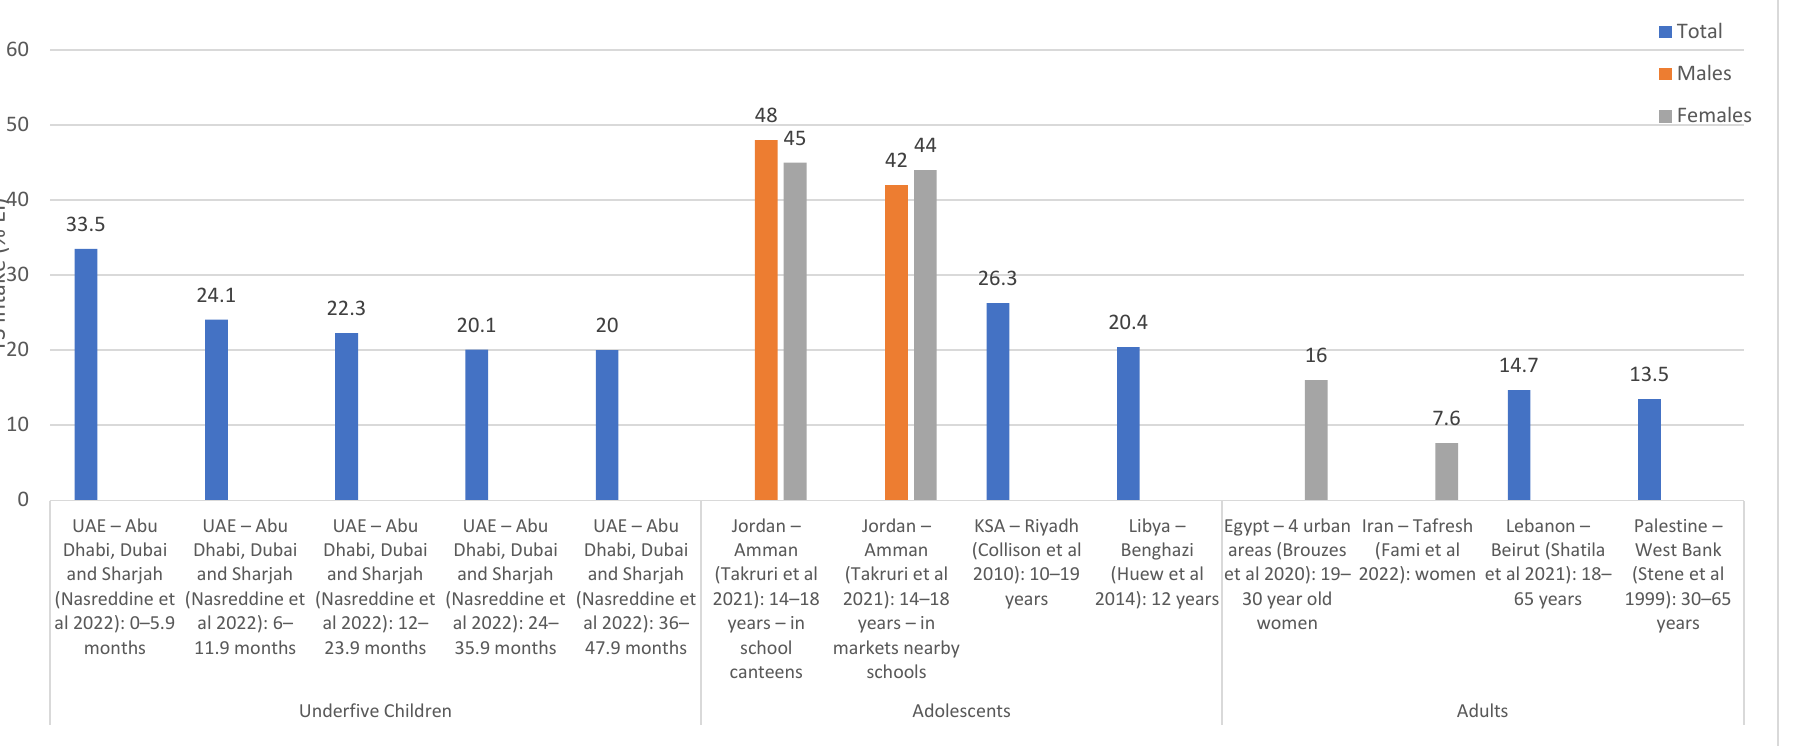
Figure 3. TS intake estimates (% EI) based on regional studies in countries of the EMR. Abbreviations: EI: energy intake; EMR: Eastern Mediterranean Region;